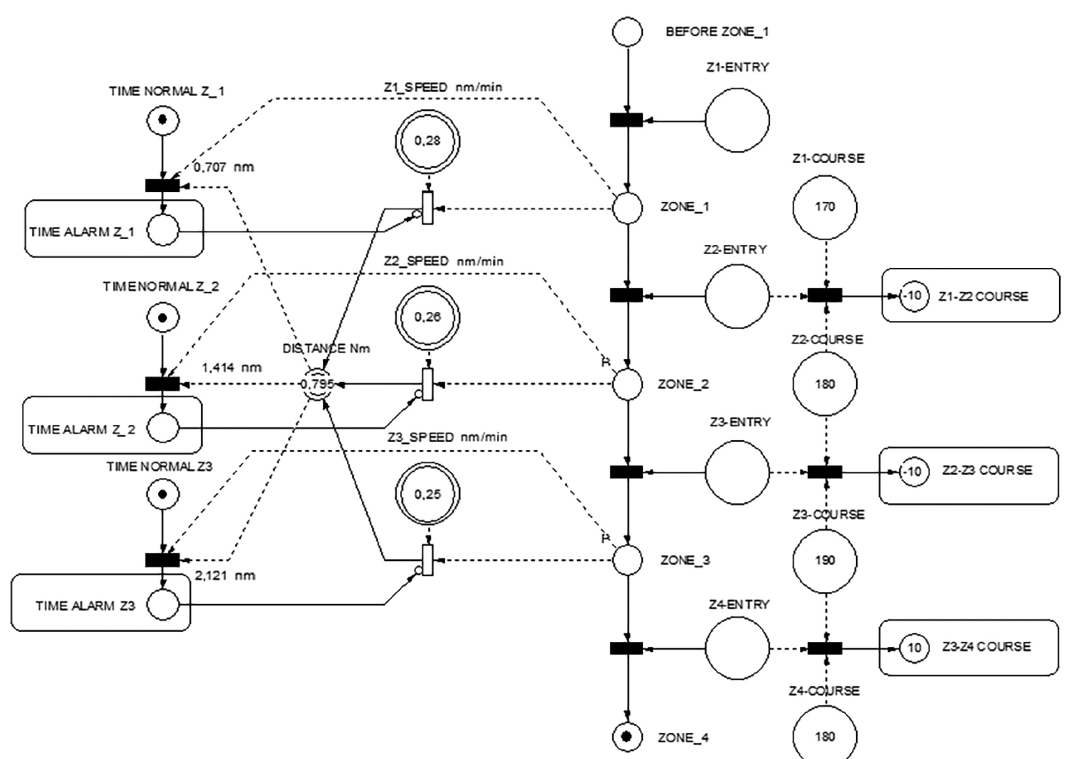
Figure 9. Hybrid Petri net model of the VTS supervisor – ship on route